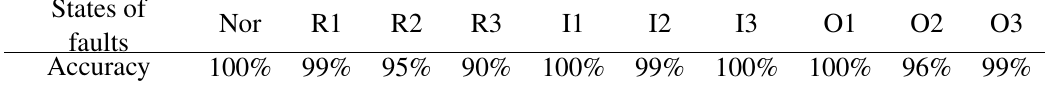
Table 4 The statistics of the overall training results using